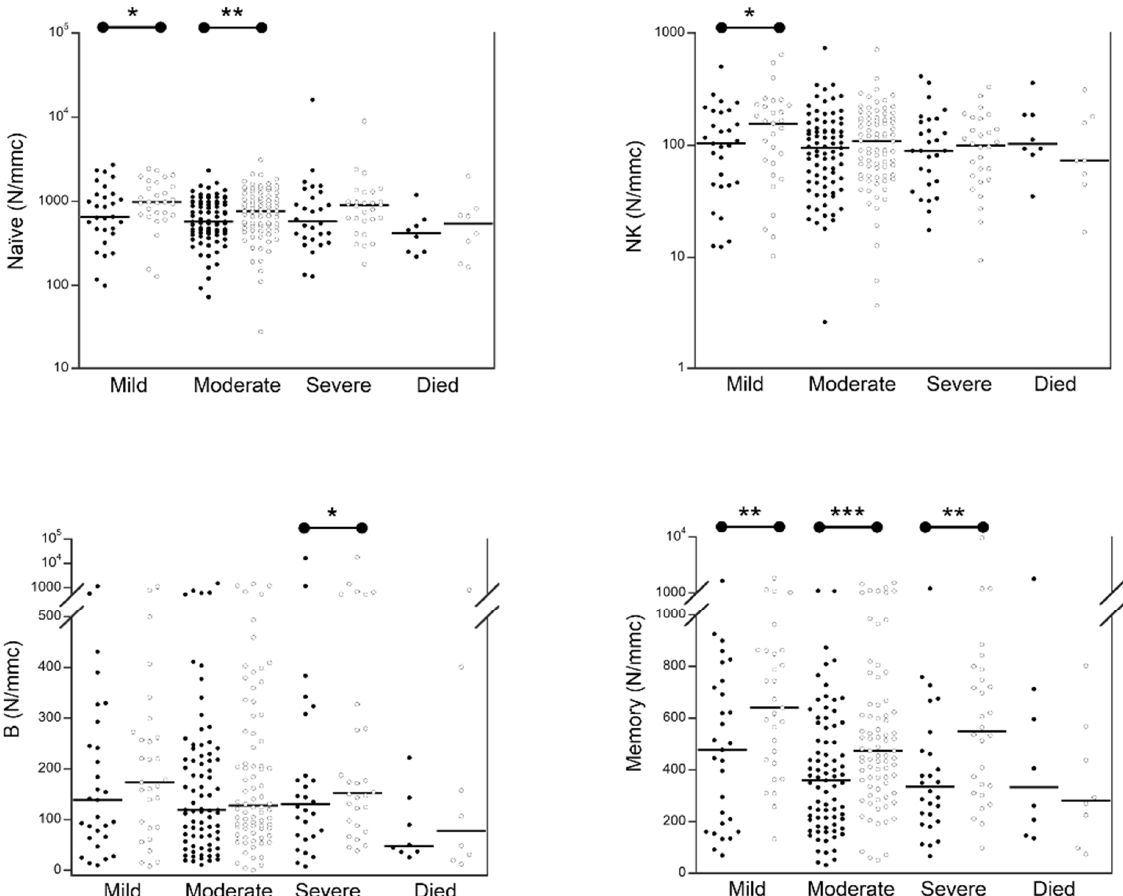
Figure 2. Comparison of circulating lymphocyte subpopulations in 144 COVID-19 patients with different severity at hospital admission (black circle) and after 1 week (white circle). The black lines represent the median values. * p < 0.05; ** p < 0.005; *** p < 0.0005.